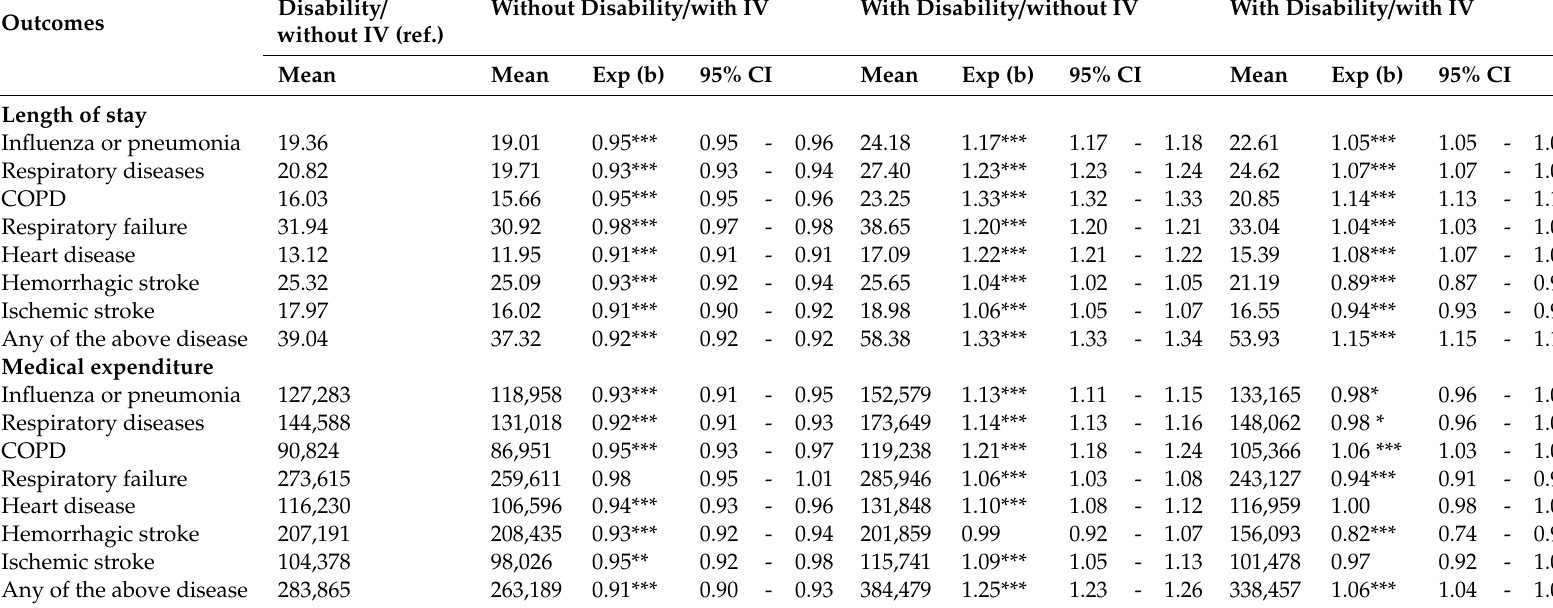
Table 4. Comparing the length of stay and medical expenditure between elderly individuals according to the presence of a disability and according to whether the vaccine was